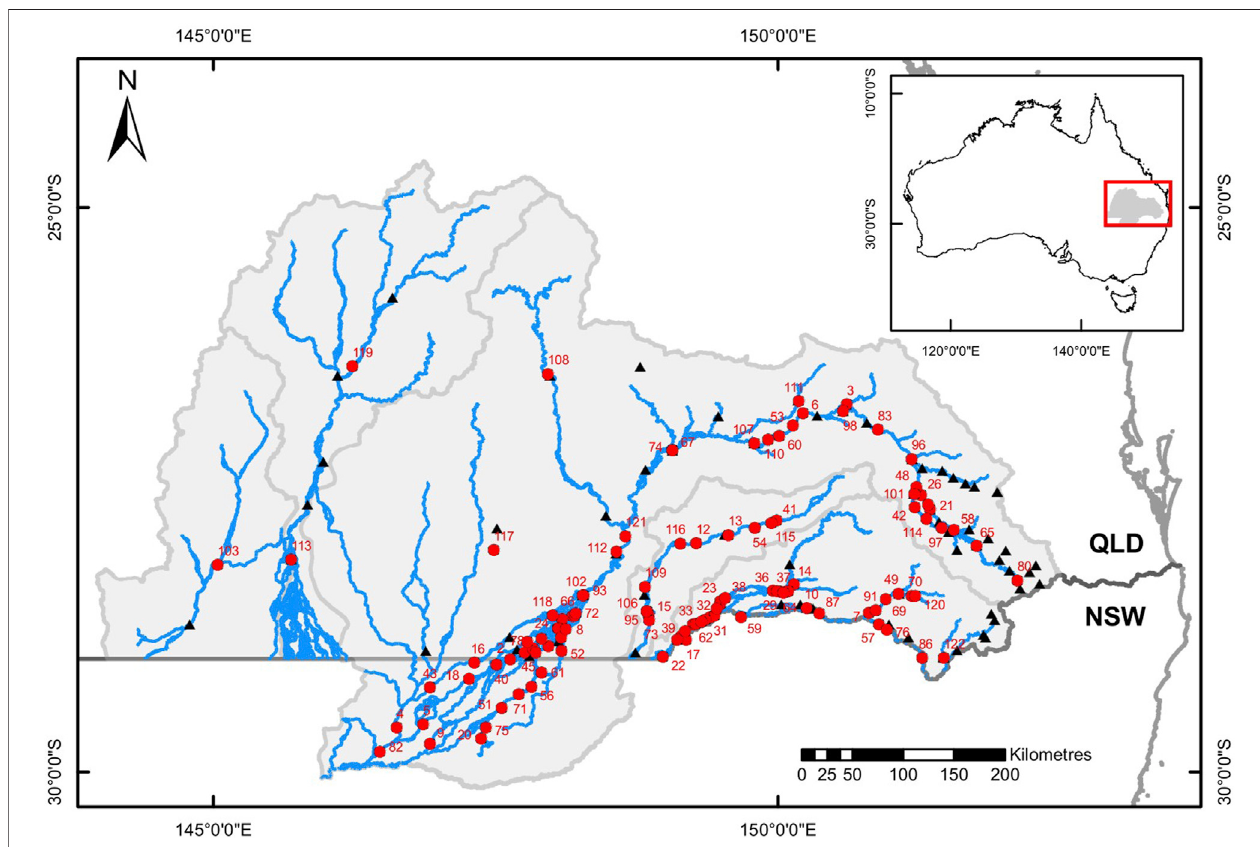
FIGURE 1 | Map of the study area showing the river network (blue lines), catchment boundaries (light grey lines), the border between the Australian states of Queensland (QLD) and New South Wales (NSW – dark grey line), with numbered red circles the locations and identities (as listed in Supplementary Table S2 ) of instreambarriers,andblacktrianglesrepresentingthelocationsofstreamgaugingstationsassociatedwithinstreambarriers.Insertmapshowsthelocationofthestudy area within Australia.